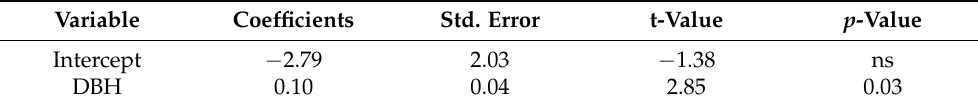
Table 3. Results from a generalized linear model produced to assess the influence of tree-related factors (DBH: diameter at breast height, cm) on the number of parentage relations assigned to each parent tree. ns: non-significant ( p >